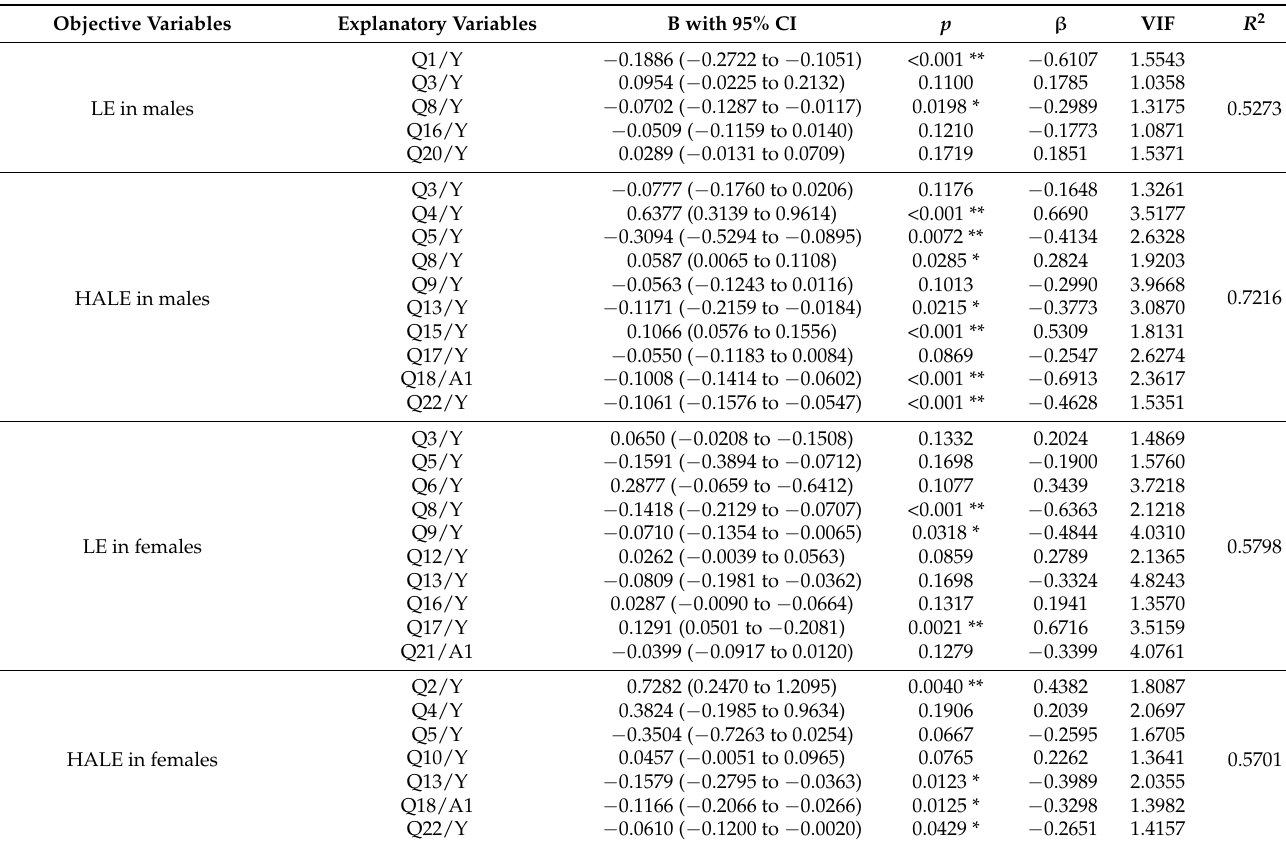
Table 7. Multiple regression analysis between population health and questions on health habits as explanatory variables. Objective